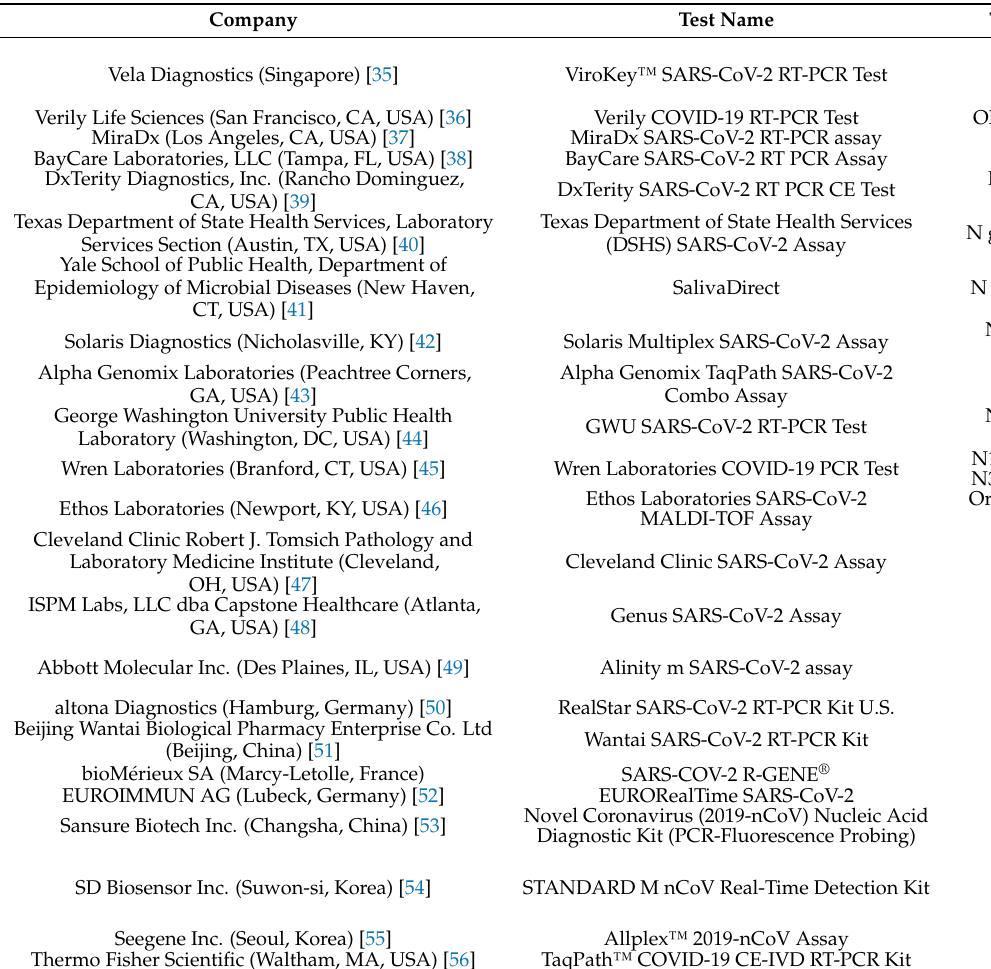
Table 1. A selected list of the FDA EUA approved real-time PCR-based tests and their performance for COVID-19